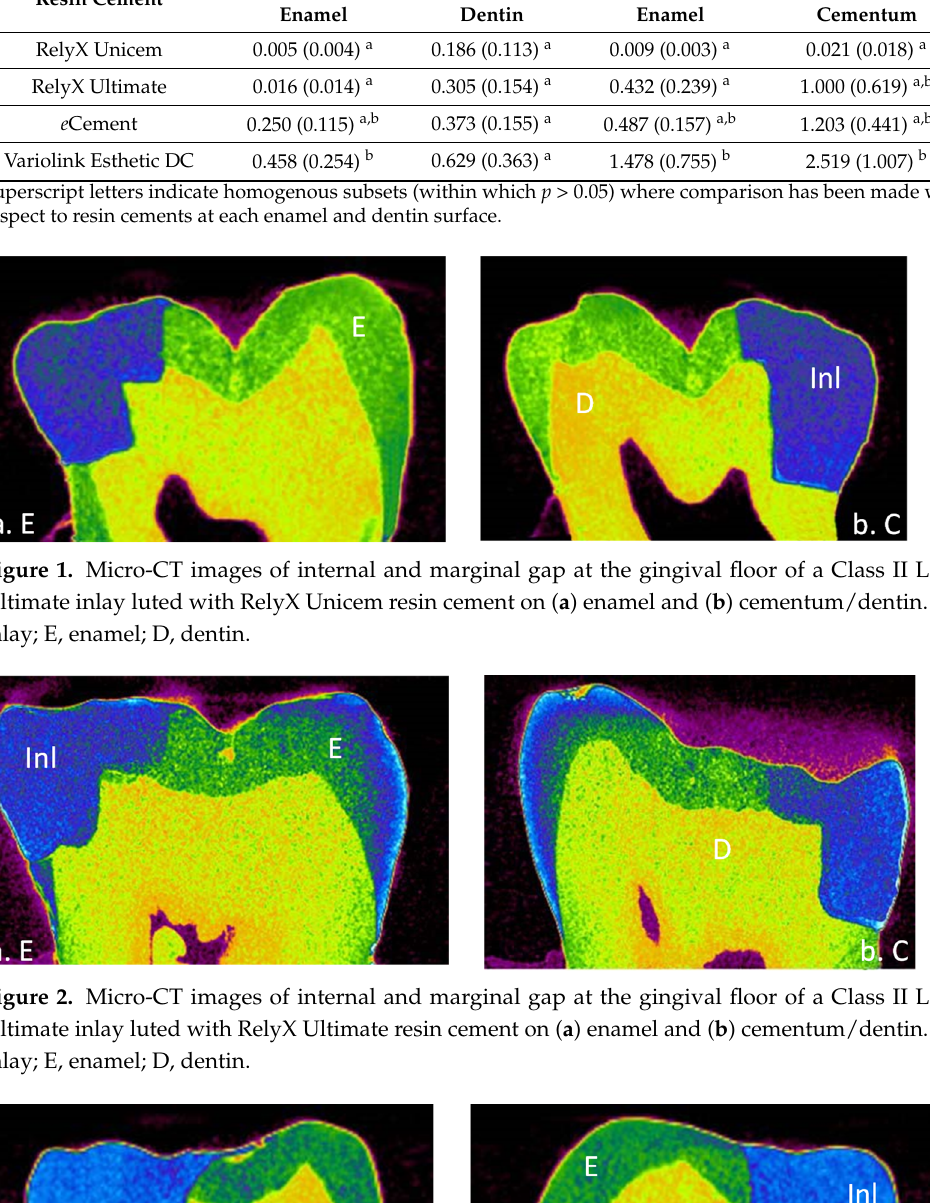
Figure 4. Micro-CT images internal and marginal gap at the gingival floor of a Class II Lava Ultimate inlay luted with Variolink esthetic DC resin cement on ( a ) enamel and ( b ) cementum/dentin. Adhe- sive layer contains: solid arrow, silver deposits; dotted arrow, void. 3.1. Comparison of Internal Gap Volume Associated with Different Types of Resin Cements One-way ANOVA showed a significant difference in the internal gap volume be- tween the four resin cements groups on enamel ( p = 0.002), but not for dentin ( p = 0.078) (Table 3). Multiple comparisons Tukey’s post hoc test showed that the internal gap vol- ume for Variolink Esthetic DC is significantly higher than that for RelyX Unicem ( p = 0.003) and that for RelyX Ultimate ( p = 0.004) on enamel surface. 3.2. Comparison of Marginal Gap Volume Associated with Different Types of Resin Cements One-way ANOVA showed a significant difference in the marginal gap volumes be- tween the four resin cements groups on enamel and on cementum ( p < 0.05) (Table 3). Multiple comparisons Tukey’s post hoc test showed that the marginal gap volume for Variolink Esthetic DC is significantly higher than that for RelyX Unicem on enamel ( p = 0.006) and cementum ( p = 0.008) and higher than that for RelyX Ultimate on enamel ( p < 0.05). 3.3. Comparison of Internal and Marginal Gap Volumes on Enamel vs. Cementum Surface The t-independent test showed that the internal gap volume is significantly greater on dentin than on enamel for RelyX Unicem, and RelyX Ultimate cements ( p < 0.05). Whereas, internal gap volume is not significantly different on dentin vs. enamel for e Ce- ment ( p = 0.249) and Variolink Esthetic DC cement ( p = 0.468) (Table 3 and Figure 5). The t-test also showed that the marginal gap volume is significantly greater on cementum than on enamel for e Cement ( p = 0.022). However, marginal gap volume showed no significant differences on enamel vs. cementum for RelyX Unicem, RelyX Ultimate, and Variolink Esthetic DC cements ( p > 0.05) (Table 3 and Figure 6).